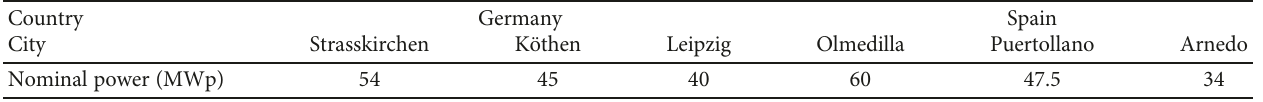
Table 4: Some of the largest photovoltaic power plants in Germany and Spain. Country Nominal power (MWp)